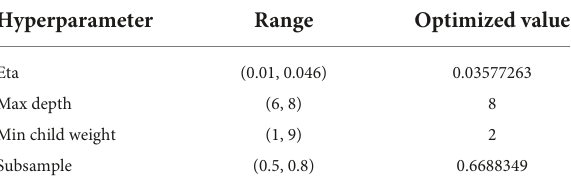
TABLE 2 Main hyper-parameter range and optimized